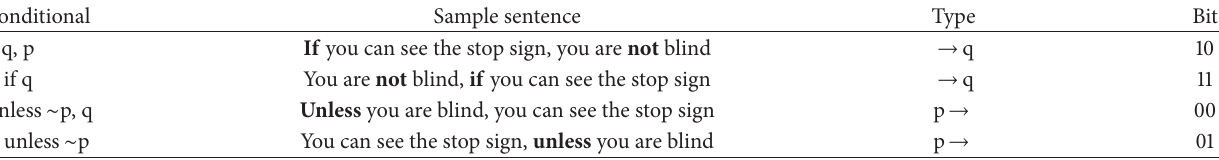
Table 5: Encoding the interchanging of p → type and → q type conditionals and swapping the independent and Dependent clauses.